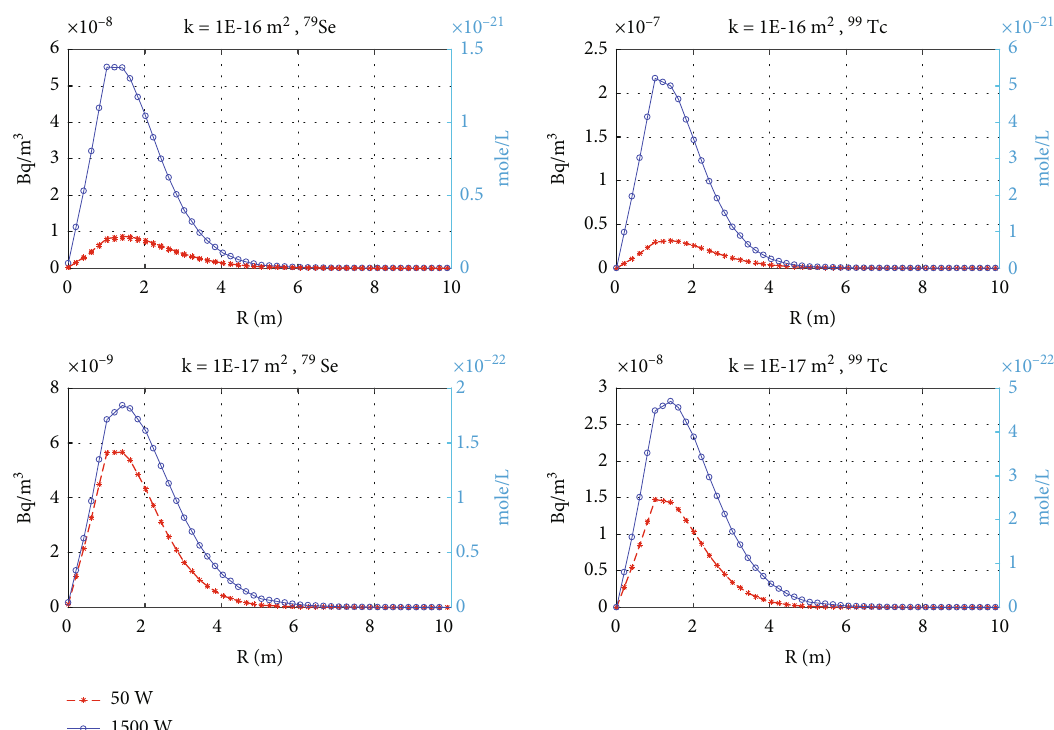
Figure 10: Activity concentration (Bq/m 3 and mole/L) at year 500 for 79 Se and 99 Tc at Z = − 250m for varying permeability ( k = 10 − 16 m 2 (a, b) and k = 10 − 17 m 2 (c, d)) and a 0.5km deep disposal